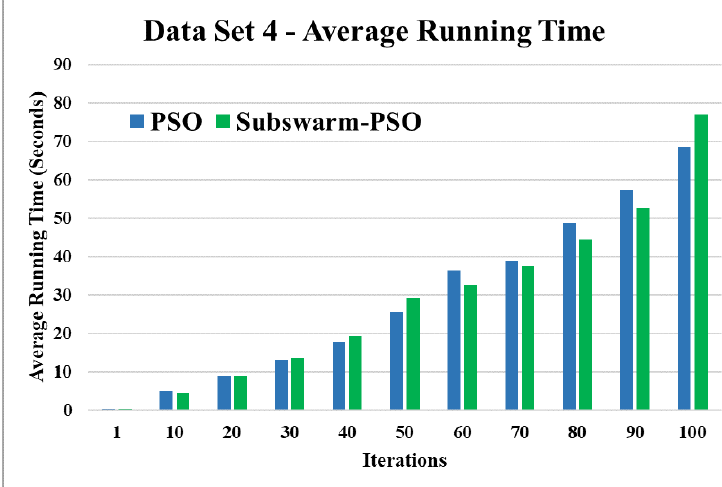
Figure 12. Average running time for data set